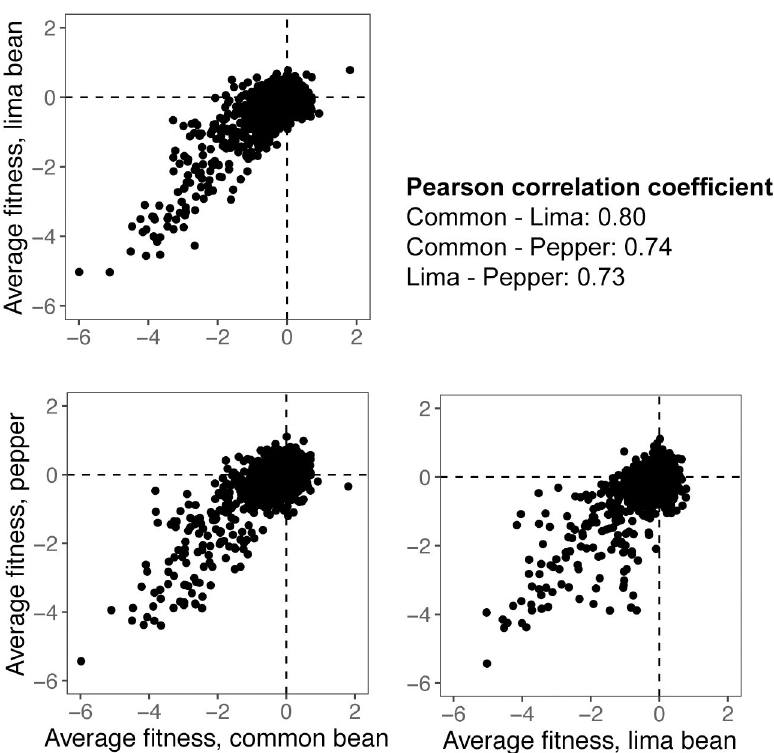
Fig 2. Pairwise comparisons of gene fitness values between plant hosts. There is a high correlation between gene contributions to growth of Pseudomonas syringae in the apoplast of common bean, lima bean, and pepper.